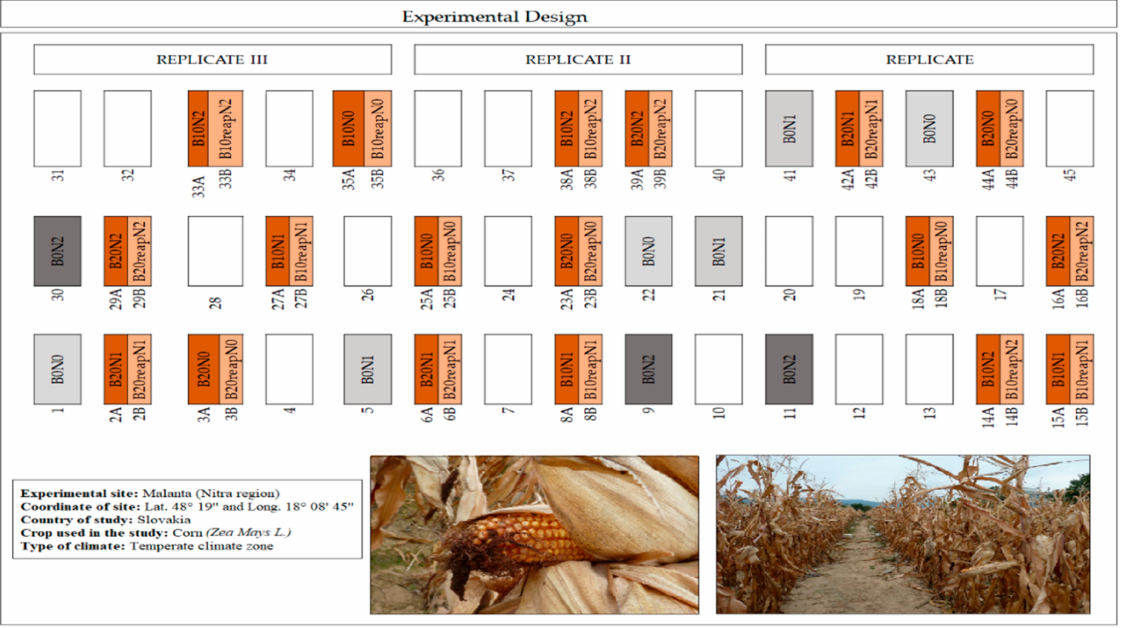
Figure 1. Schematic arrangement of the experimental site with 27 highlighted plots which were used in this study: A—subplots with the biochar applied in 2014 only; B—subplots with the biochar reapplied in 2018; and plots with control treatments without the biochar but with different rates of the mineral